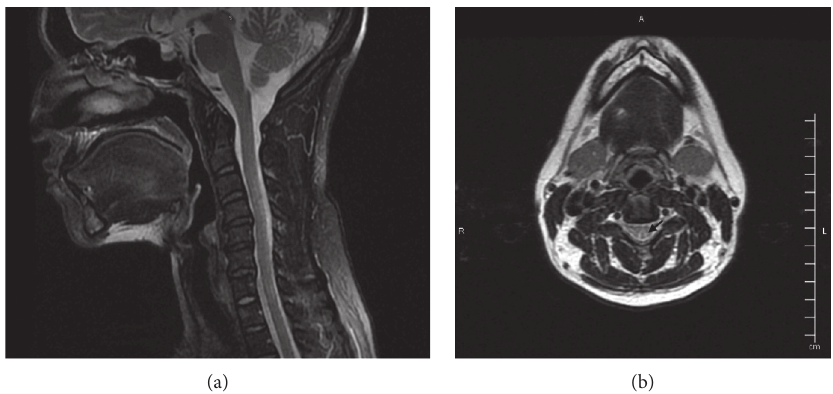
Figure 1: Case 2 MR C spine with and without contrast performed on 9/18/20 demonstrating a segmental abnormal signal within the dorsal columns of the cervical cord. (a) Sagittal cut T2-weighed imaging. (b) Axial cut T2-weighed imaging. Arrow: dorsal columns are prominently visualized and